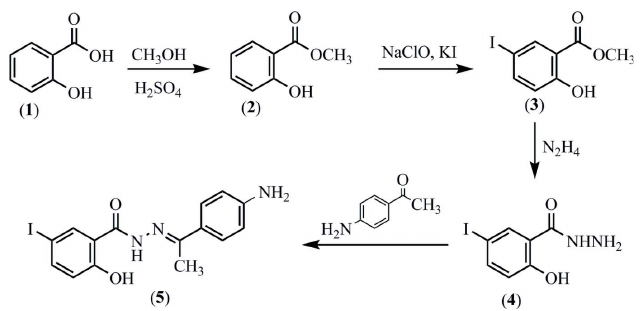
Figure 8 Reaction scheme for the title compound.